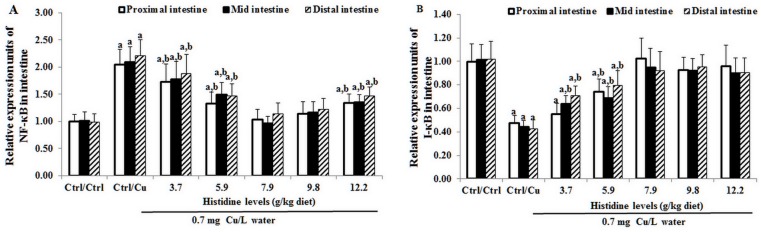
Cu induces an increase in NF-κB (A) and IκB (B) mRNA levels in fish intestine.The protocol and indications are shown in Fig 3. NF-κB, nuclear factor kappa B; IκB, inhibitor protein-κB.